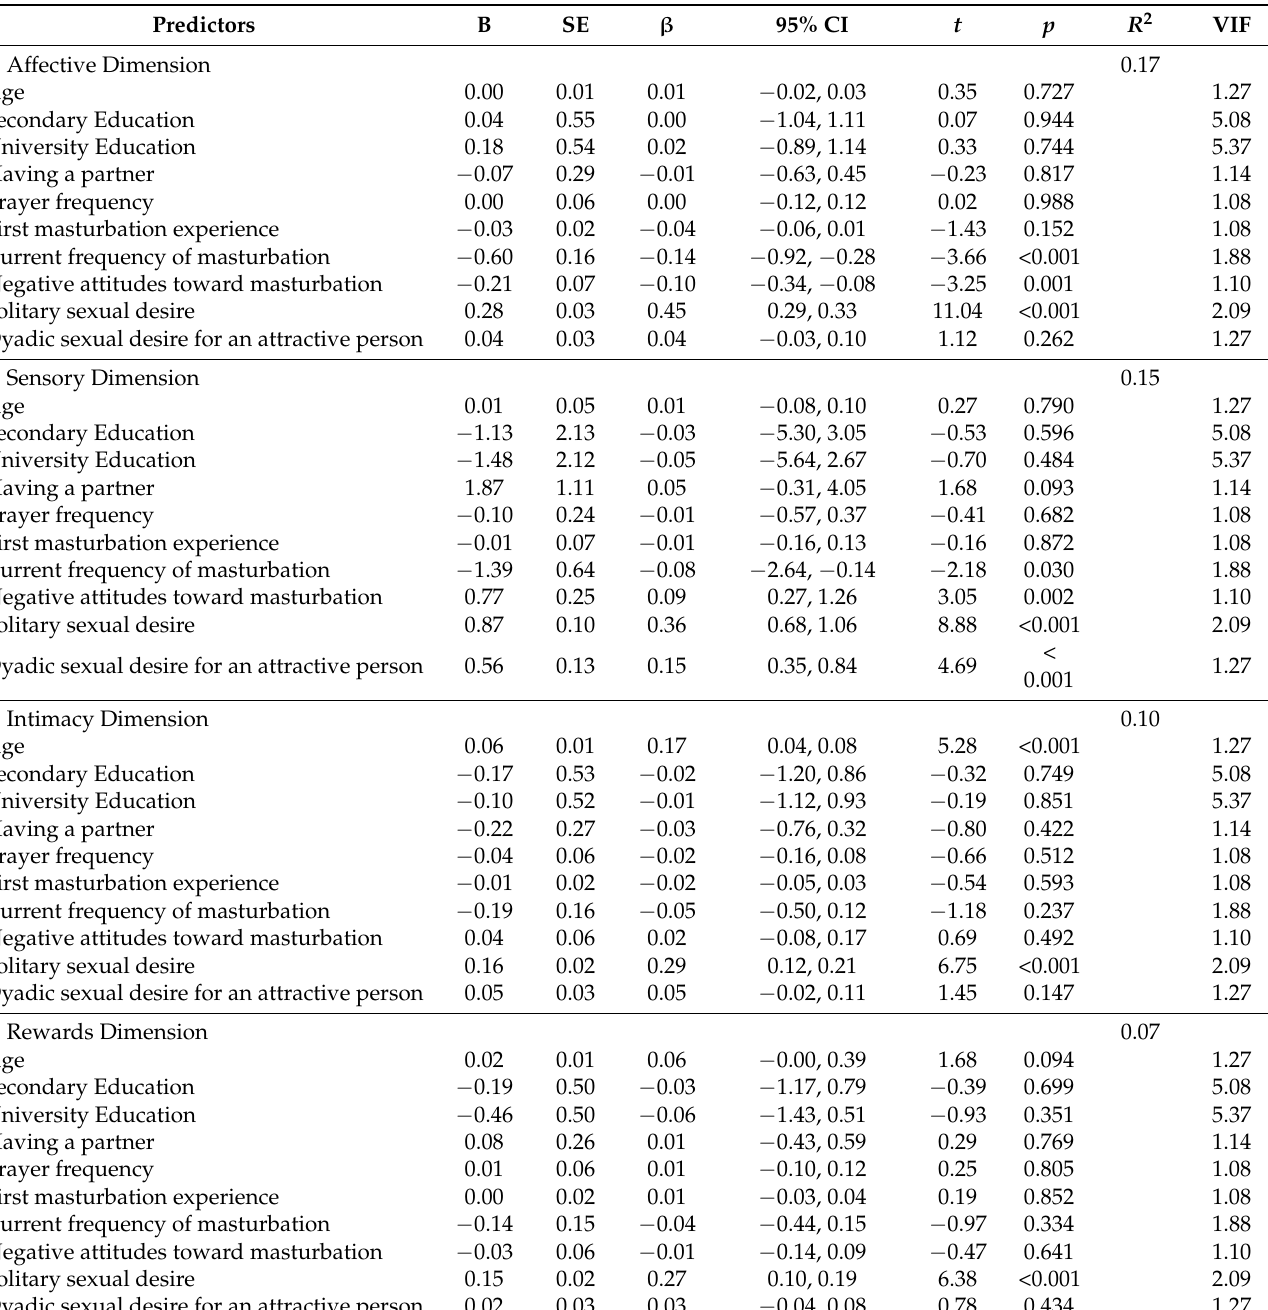
Table 4. Multiple linear regression models for the four dimensions of the subjective orgasm experience in